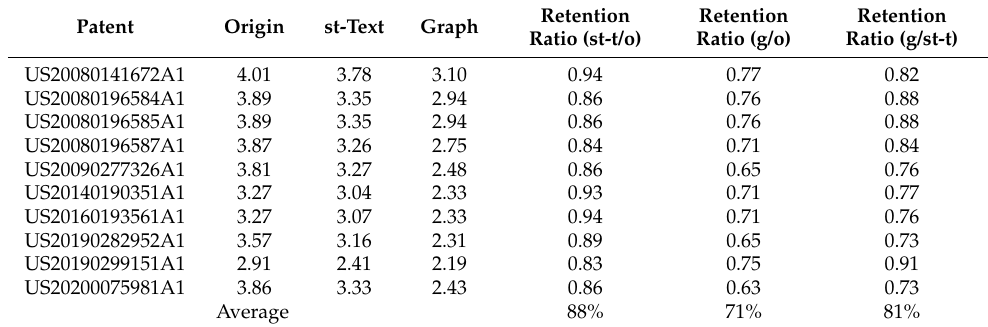
Table 3. Cluster 3 validation results.